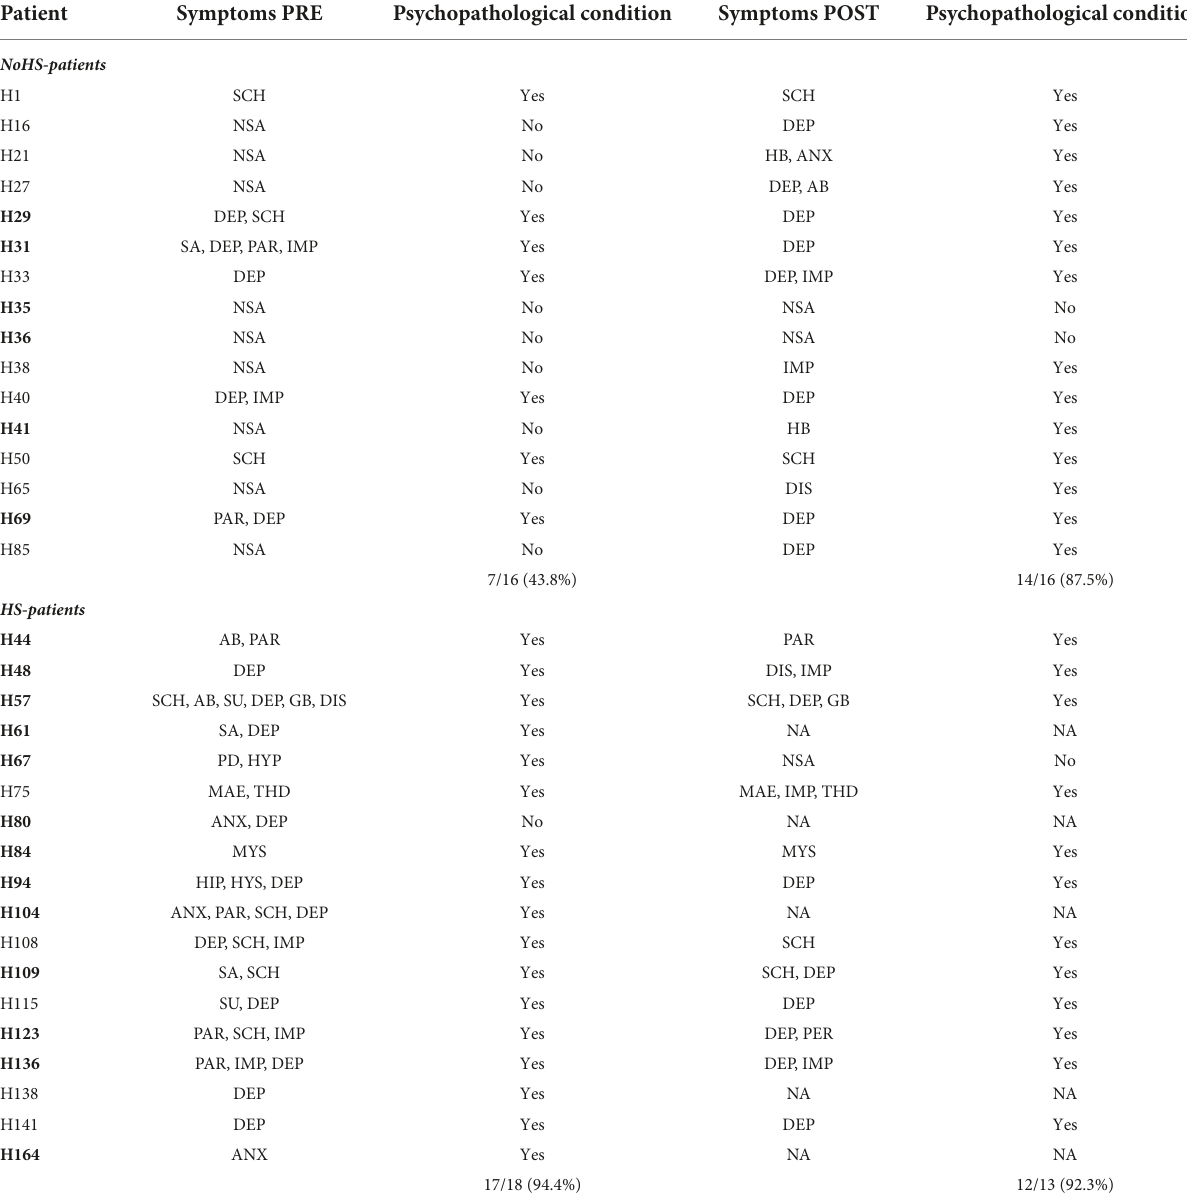
TABLE 5 Summary of the brief clinical interview, which revealed psychopathological symptoms. Patient Symptoms PRE Psychopathological condition Symptoms POST Psychopathological condition